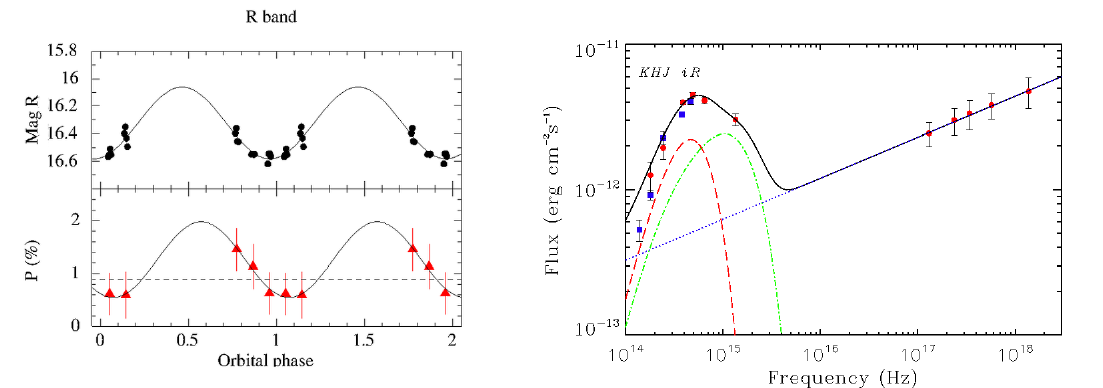
Figure 2. Left panel, up: R –band light curve of J1023 (magnitude vs. orbital phase). With a solid line, a fit of the light curve with a sinusoidal function with period fixed to 1 (corresponding to 4.75 hr) is reported. The χ 2 /dof of the fit is 11.35/17; bottom: R –band polarisation curve represented with respect to the orbital phase of the system. Superimposed, the fits with a constant function (dashed line; χ 2 /dof = 3.66/4) and with a sinusoidal function with period fixed to 1 (solid line; χ 2 / dof = 0.11/2). Errors are represented at the 68% confidence level. Two periods are drawn for clarity. Right panel: NIR– optical contemporaneous SED of J1023 obtained in this work (orbital phase 0.59; blue squares); the NIR–X-rays SED of J1023 reported in [23] is also represented (red dots), with superimposed the fit with a model made by the companion star (red dashed line), the accretion disc (green dash-dotted line) and the shock emission powered by the neutron star (NS) spin down luminosity (blue dotted